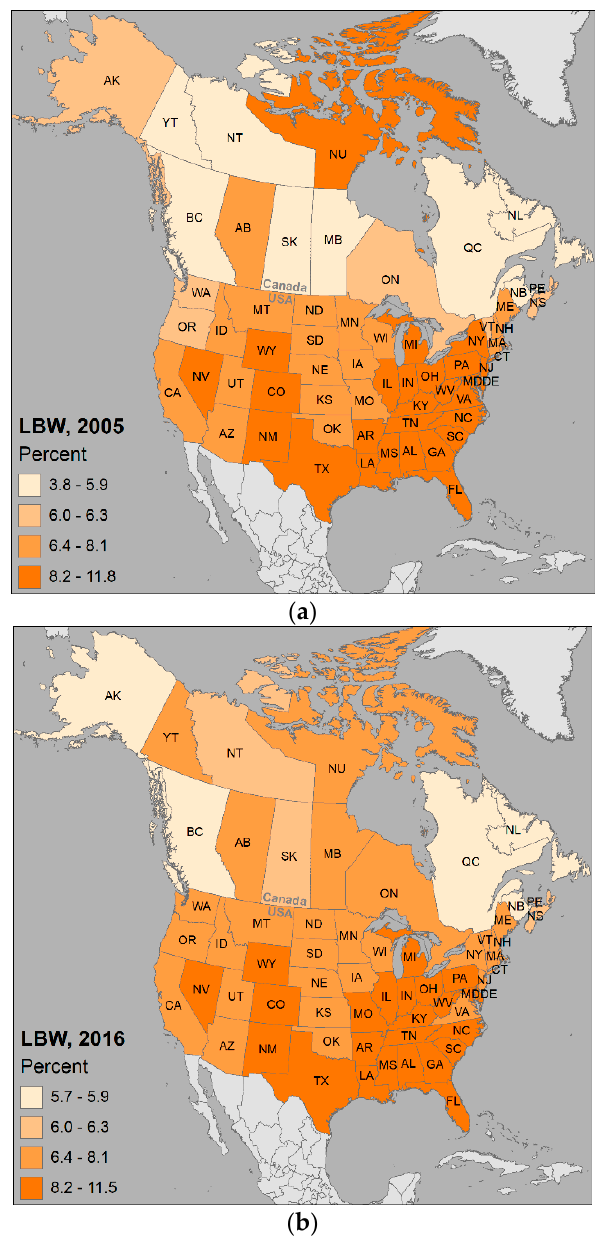
Figure 2. Percentage births considered low birth weight (LBW (all gestational ages)) in Canada and the USA for: ( a ) the year 2005; ( b ) the year 2016.